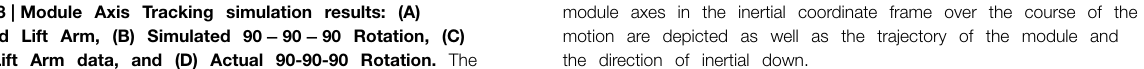
FIGURE 3 | Module Axis Tracking simulation results: (A) Simulated Lift Arm, (B) Simulated 90 − 90 − 90 Rotation, (C) Actual Lift Arm data, and (D) Actual 90-90-90 Rotation. The